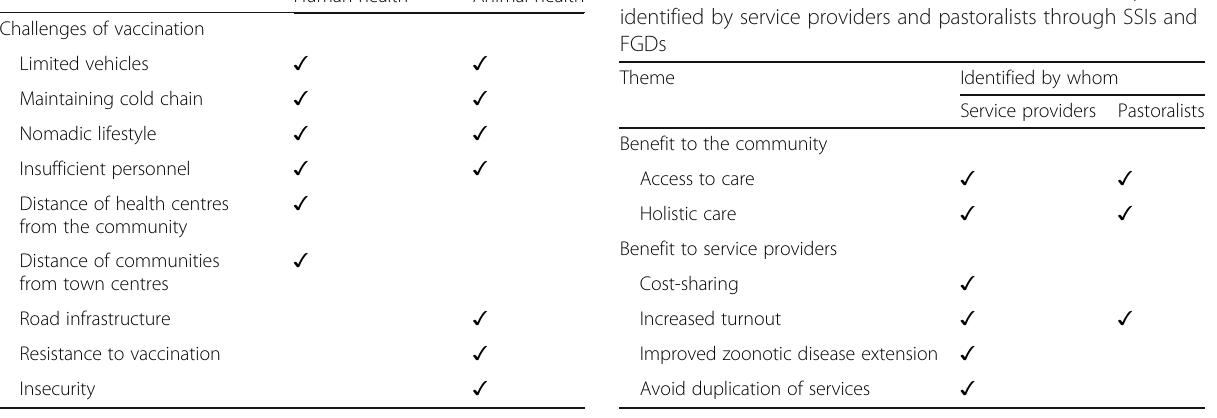
Table 6 Perceived benefits of One Health service delivery identified by service providers and pastoralists through SSIs